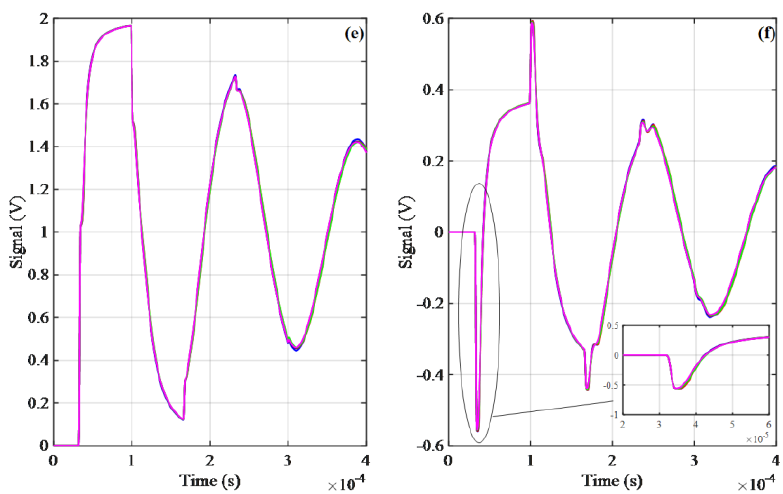
Figure 28. Transient responses at the receiving end for ℓ = 0.5 km and ( a ) conductor 1, ( b ) conductor 2, for ℓ = 1.0 km and ( c ) conductor 1, ( d ) conductor 2, for ℓ = 10.0 km and ( e ) conductor 1, ( f ) conductor 2.